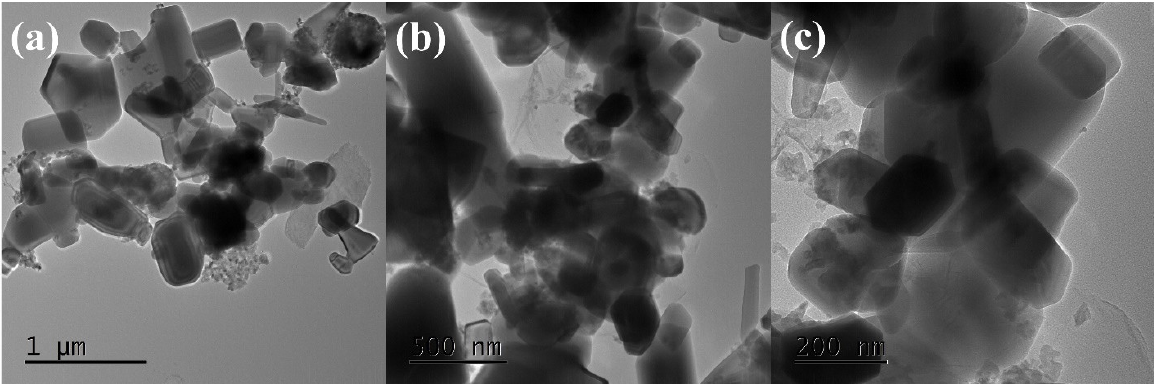
Figure 3. Transmission electron microscopy (TEM) images of rGO@ZnO–Cu nanocomposites at different magnifications. ( a ) 1μm magnification; ( b ) 500 nm magnification and ( c ) 200 nm magnification.